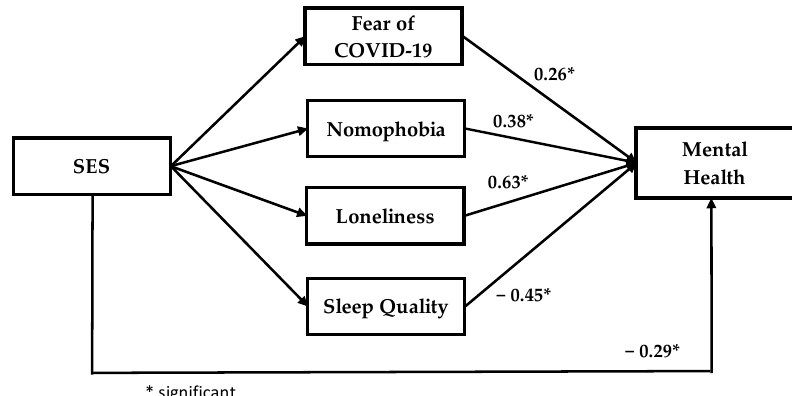
Figure 2. Output of mental health model (music students).